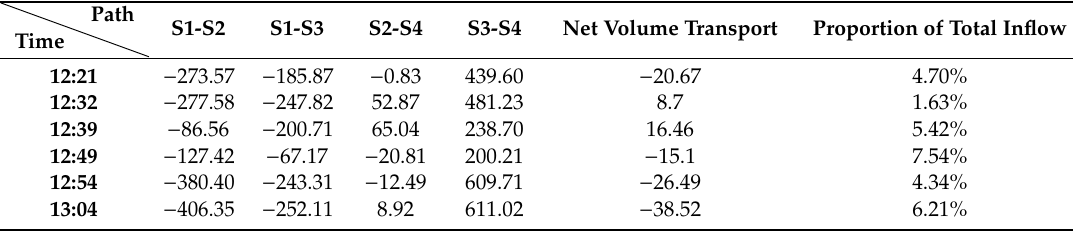
Table 4. Cross-section volume